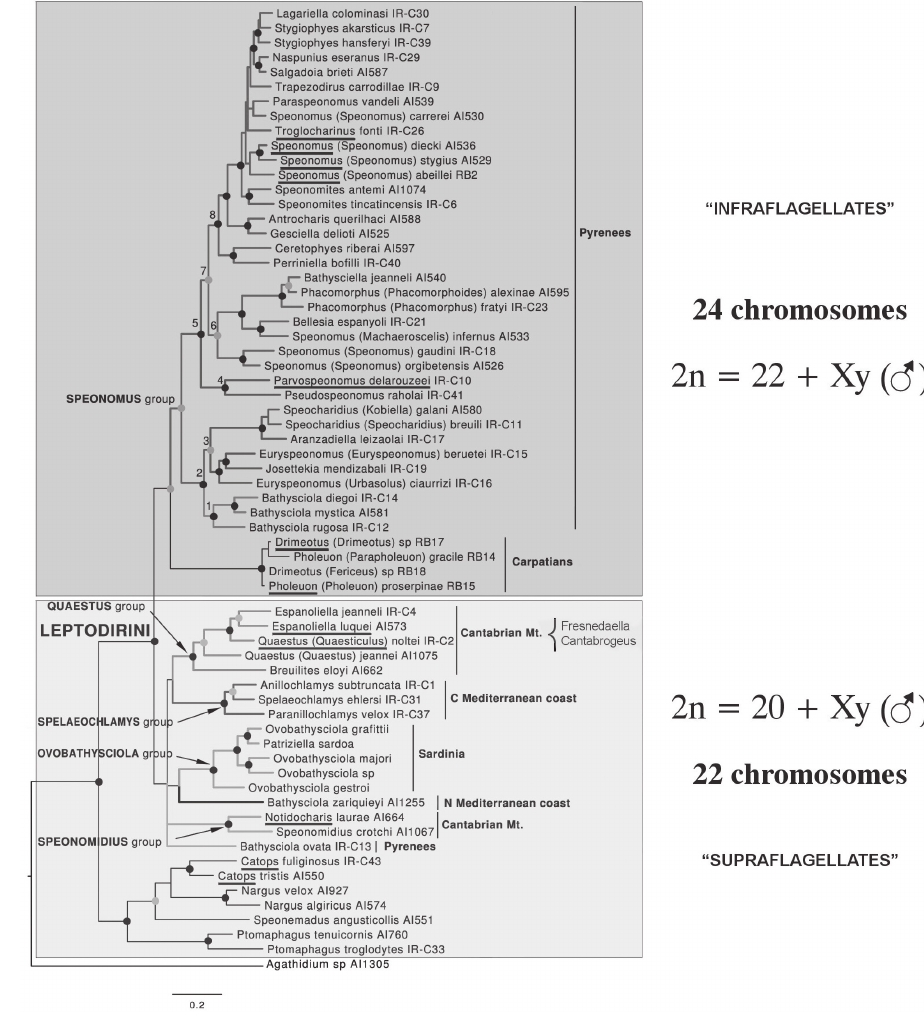
Figure 7. Phylogram obtained from Ribera et al. (2010), modified to show the reconstructed evolution of the chromosome number. Genera whose chromosome complements are known are